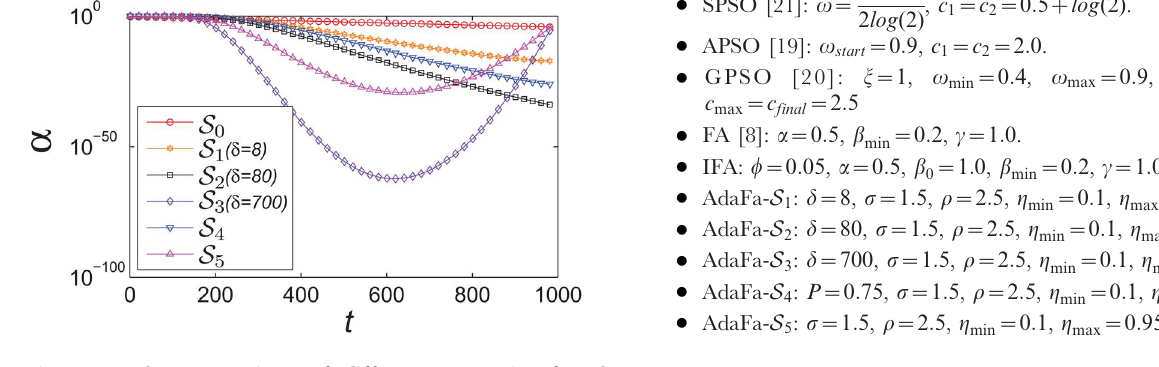
Figure 7. The comparison of different strategies for the randomization parameter a